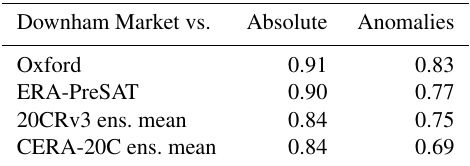
Table 4. Pearson correlation coefficients of the re-evaluated total column ozone series from Downham Market with other column ozone series. Anomalies refer to the values after subtracting the first harmonic function in terms of day of